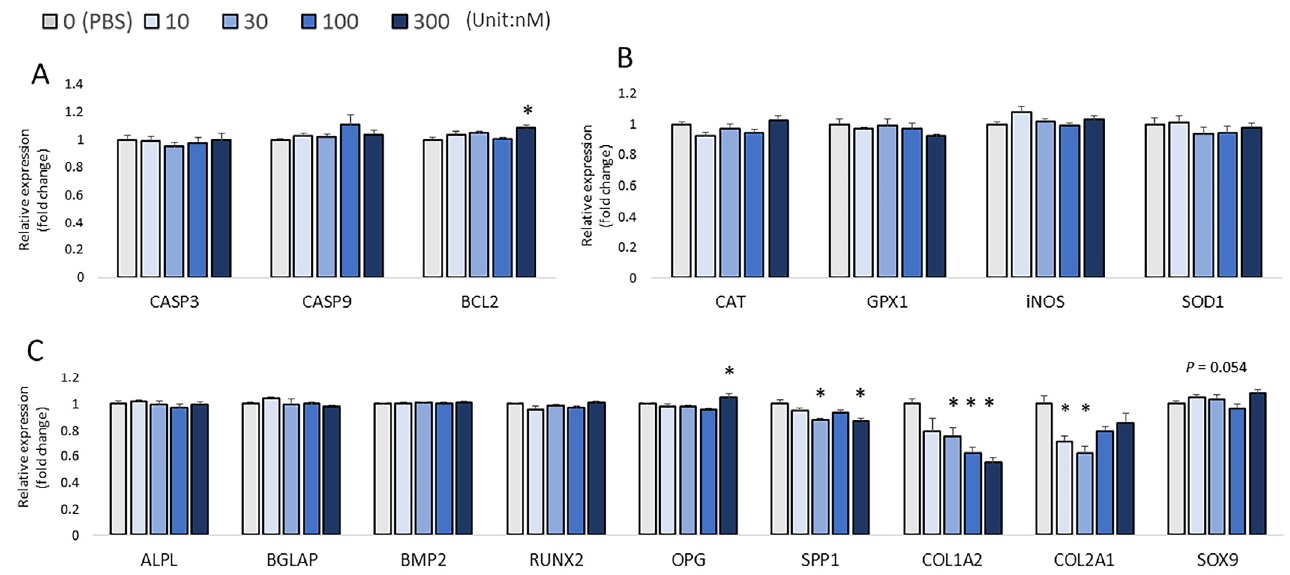
Figure 5. Effects of H 2 O 2 on the mRNA expression of several sets of genes in chicken embryos at 24 h of post-injection. ( A ) Apoptotic genes’ expression; ( B ) Antioxidant enzymes’ gene expression; ( C ) Expression of bone formation biomarkers. Each value represents the mean ± SEM (N = 8). Treatments with * showed a significant difference compared with the control using the Dunnett’s test, p < 0.05.